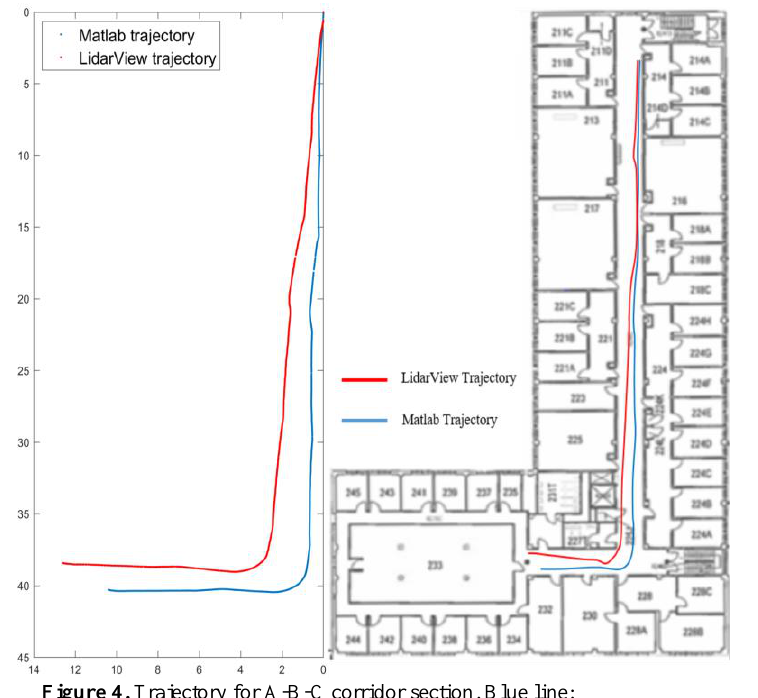
Figure 4. Trajectory for A-B-C corridor section, Blue line: Matlab trajectory, Red Line: LidarView (Left Side), Trajectory data matched with the underlying floor plan (Right